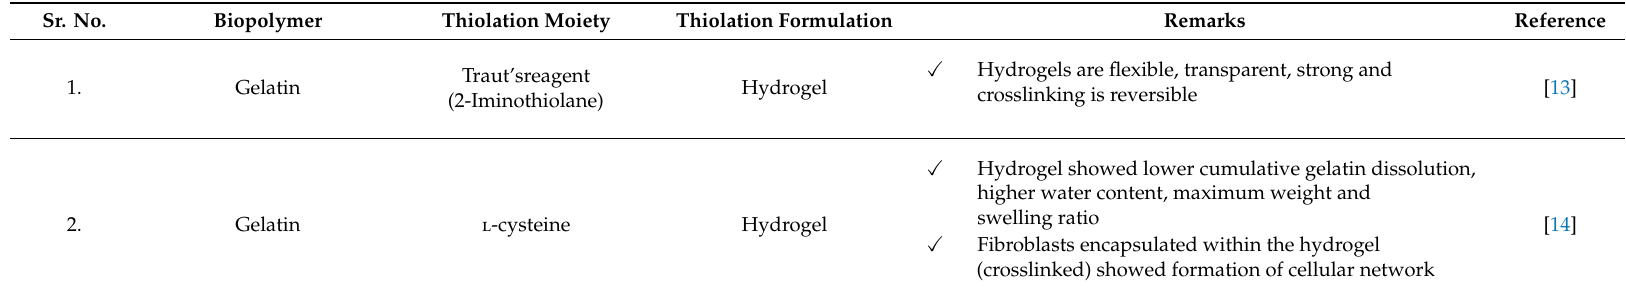
Table 2. Reported literature on thiolation of biopolymers for developing mucoadhesive formulations. Sr.